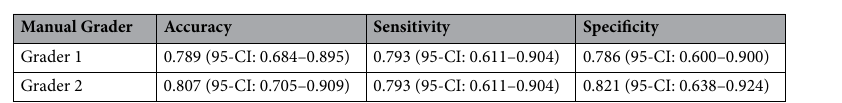
Table 5. Manual grading on the testing dataset. CI confidence